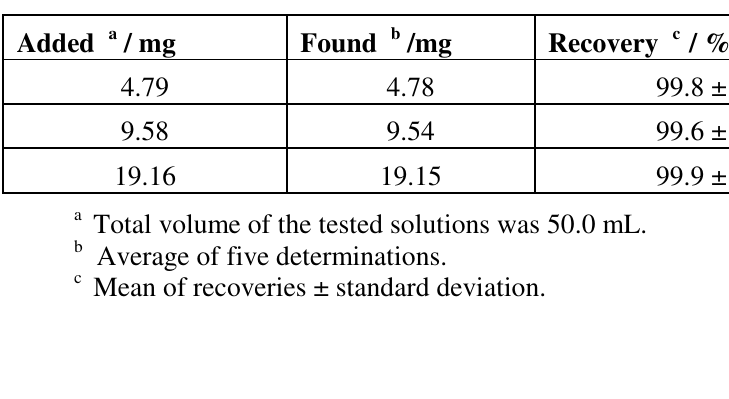
Table 3. Recovery of Metacycline